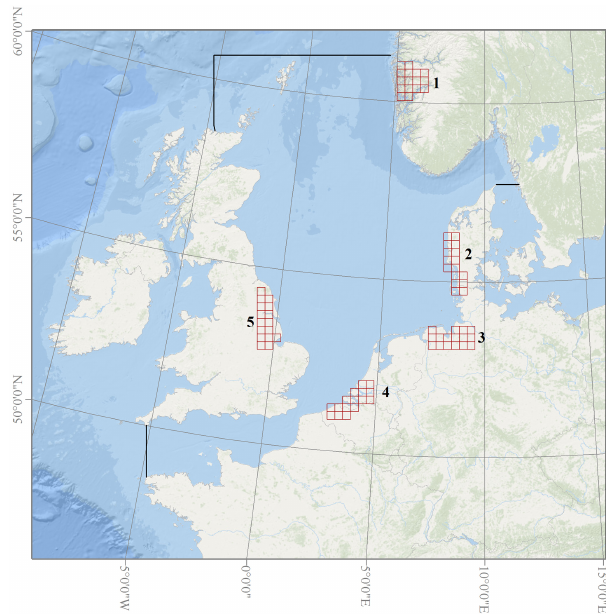
Figure 1. Modeling domain with the borders of the OSPAR region II and the cells that were defined as representative coastal areas.